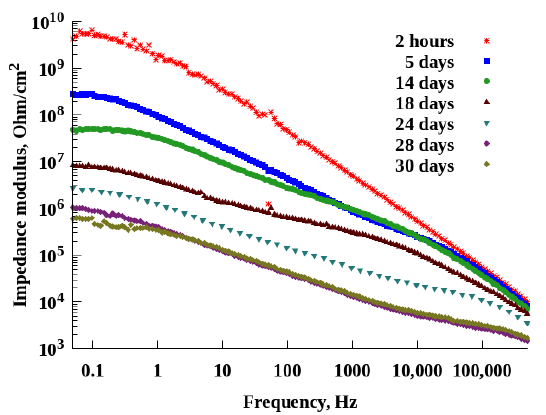
Figure 4. The evolution of the frequency dependence of the electrochemical impedance modulus for the superhydrophobic sample subjected to continuous contact with 0.5 M NaCl for 30